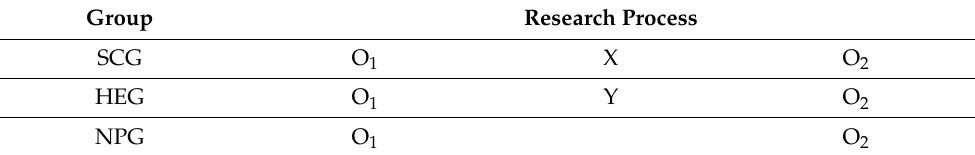
Table 1. The research design for this study.